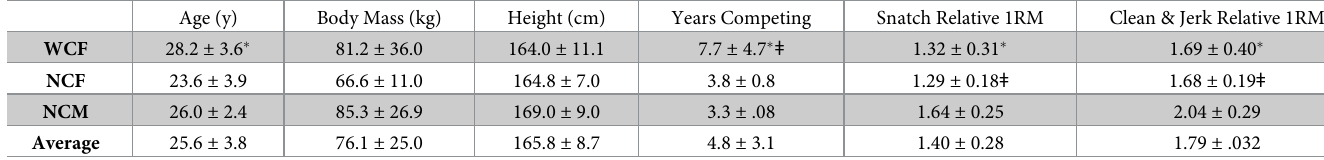
Table 2. Descriptive information of elite female and male American